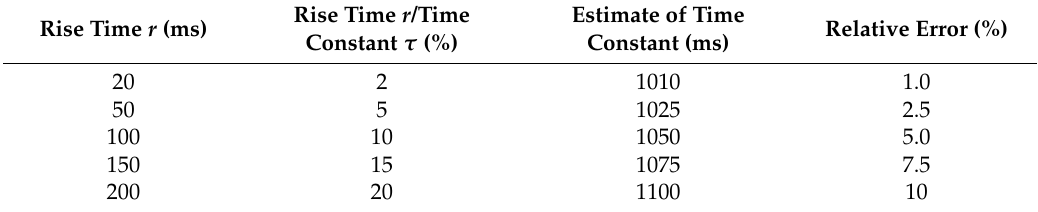
Table 1. Estimation error of time constant when ramp signal is used as excitation